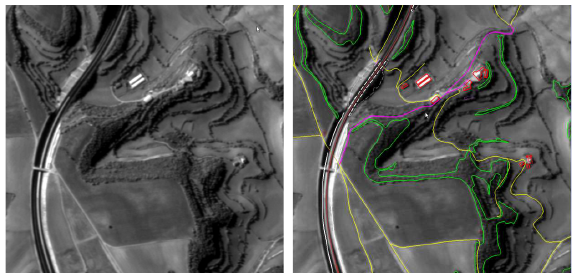
Figure 9. Example of data compiled using the Bac Forward stereopair. Left : Original vector data including paved roads (red), unpaved roads (violet), paths (yellow), embankments (white), forests (green) and buildings (regular polygons in